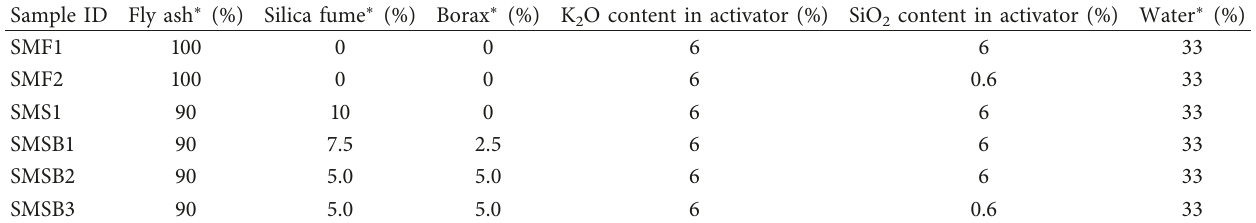
Table 2: Mix proportions of geopolymer